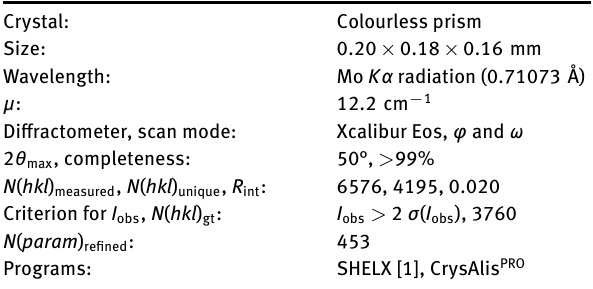
Table 1: Data collection and